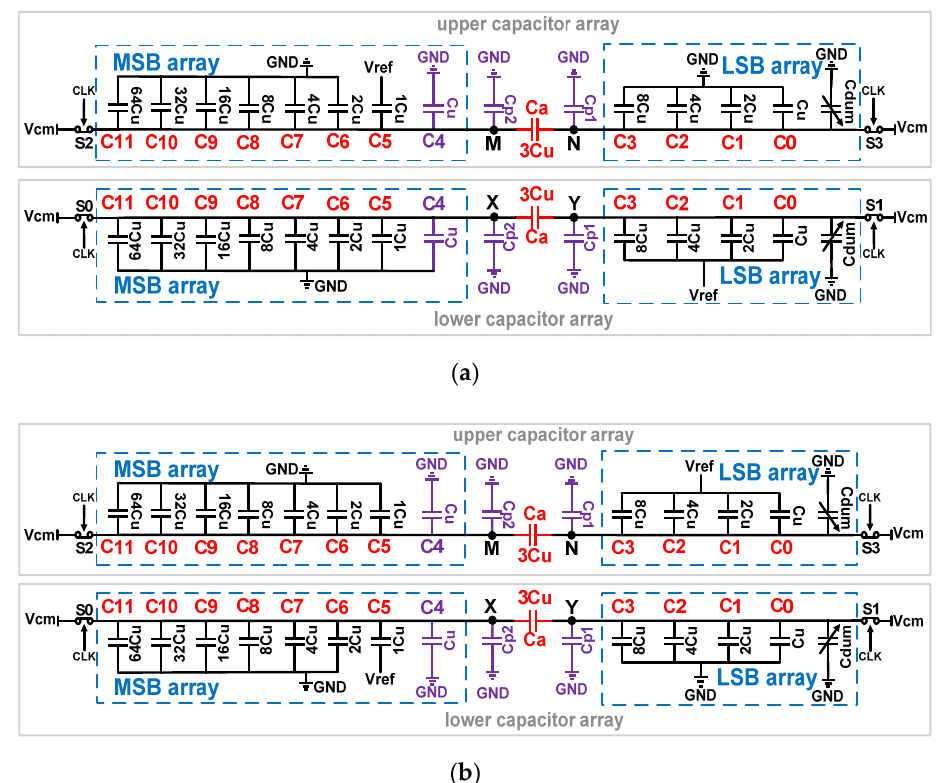
Figure 4. The proposed differential calibration method. ( a ) Sampling phase; ( b ) charge distribution phase.